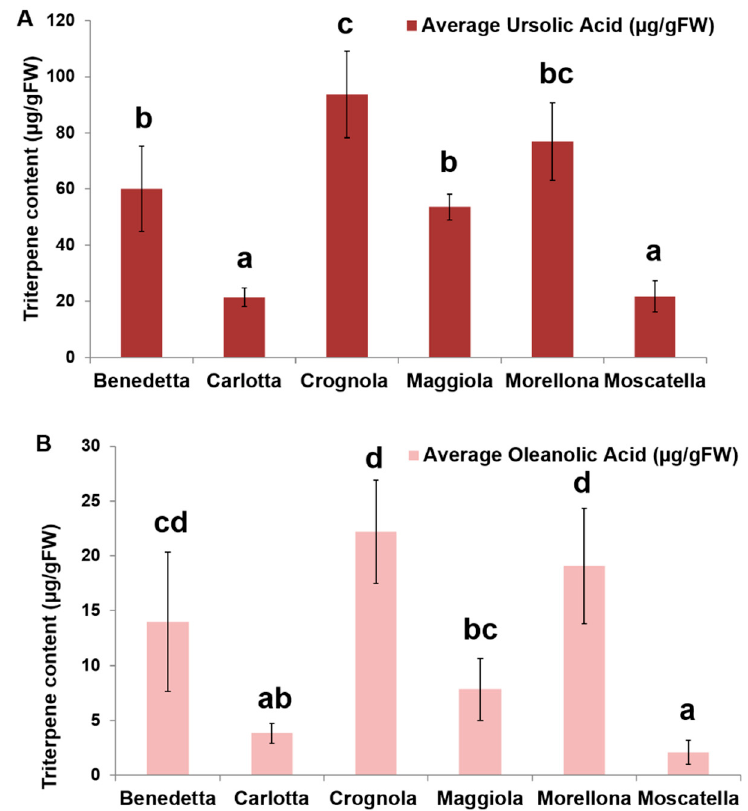
Figure 12. Triterpene composition of the Tuscan sweet cherry fruits. A : ursolic acid content; B : oleanolic acid content. Data are expressed in µ g g − 1 FW ( n = 5, with the exception of ‘Crognola’, where n = 4). Different letters indicate statistically significant differences ( p < 0.05) calculated with the Tukey’s post ‐ hoc test.